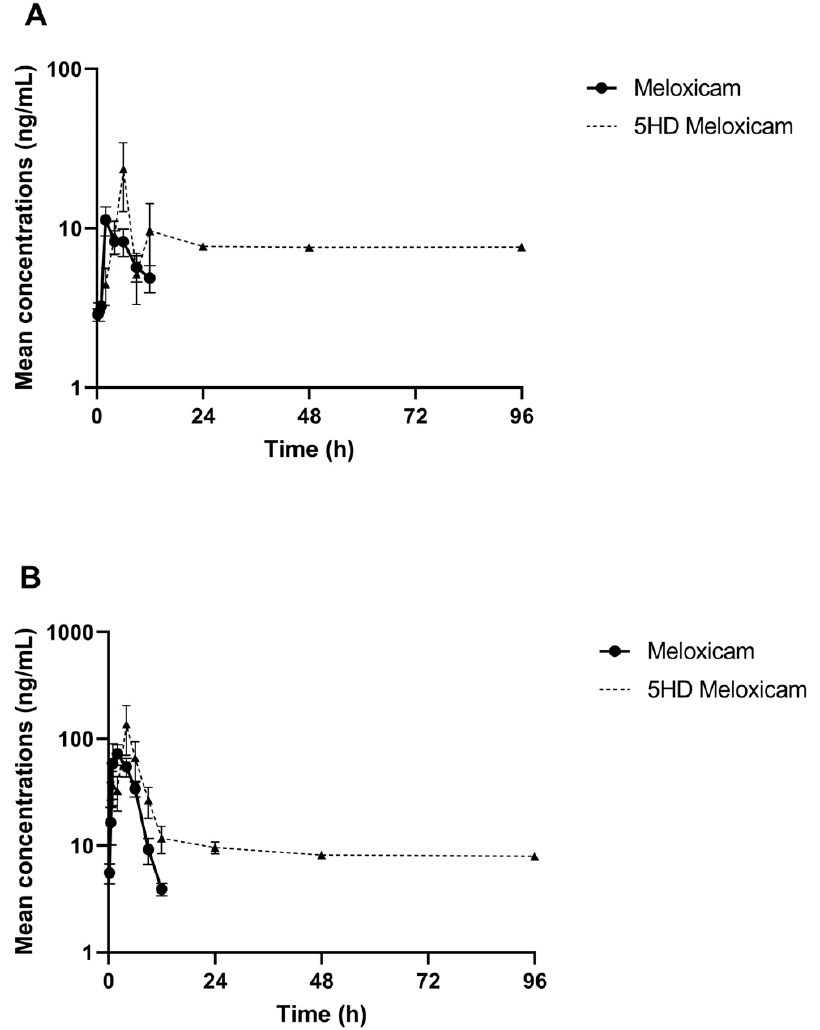
Figure 1. Mean ± SEM parent drug and metabolite concentration in plasma after administration of a single dose of meloxicam (1 mg/kg) orally ( A ) or intramuscularly ( B ) (n = 6) from 0 to 96 h post-administration in tilapia .